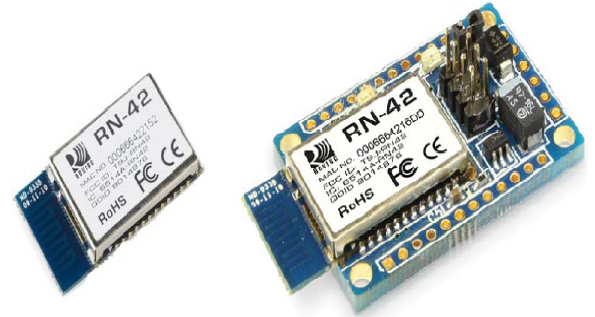
Figure 2. The RN-42 Roving Network Bluetooth module is on the left. On the right it is the RN-42 Roving Network Bluetooth module integrated in the RN-42-SM board [25].